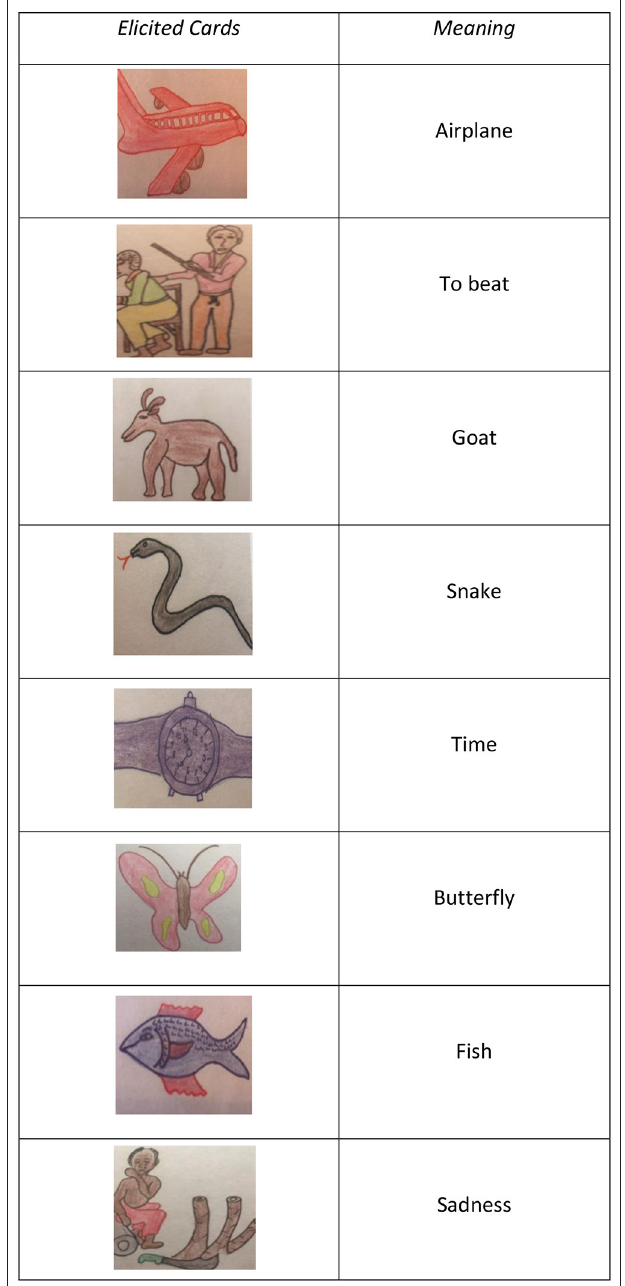
FIGURE 1 | Draws presented to the participants in the elicitation task.